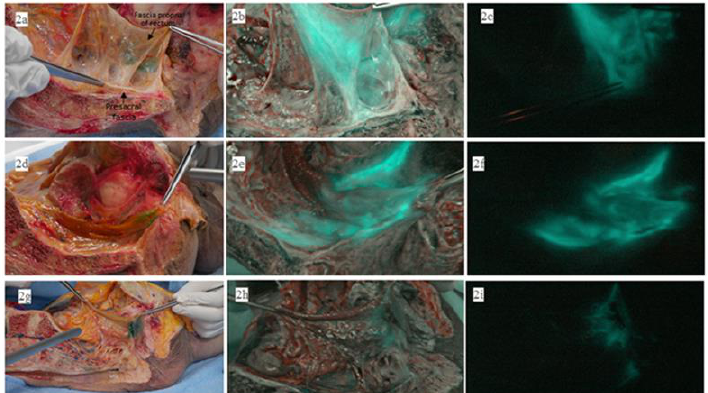
Figure 2. The macroanatomical examination of the lymphatic drainage from the distal rectum in fresh cadavers. ( a , d , g ) Multiple perforating small lymphovascular branches connect the mesorectum to the presacral fascia; ( b , e , h ) the color image overlaid with ICG fluorescence; ( c , f , i ) the pure ICG fluorescence image under NIR light.